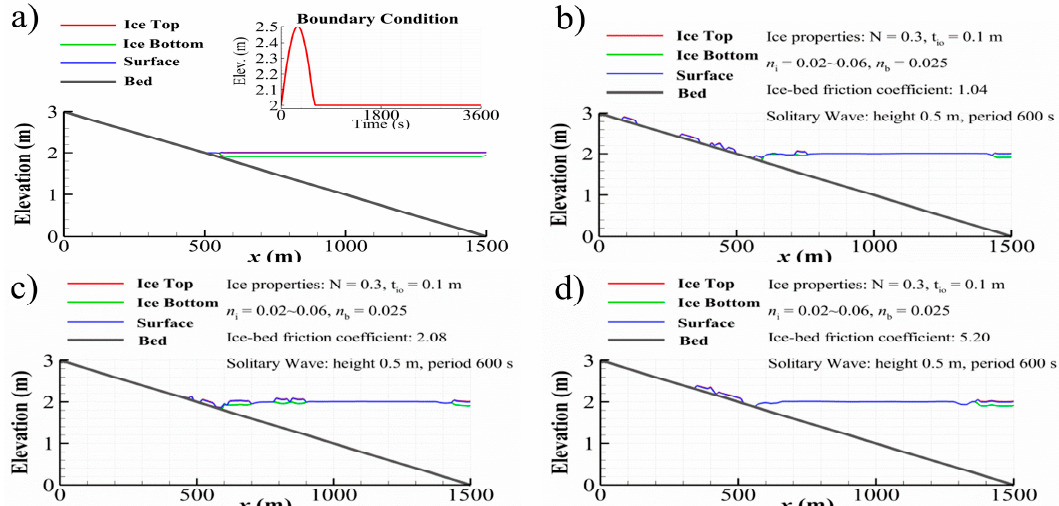
Figure 6. Simulated ice depositions on the beach under a tsunami wave with different ice-bed friction coefficients: ( a ) Initial water surface, ice bottom and top elevations, and the tsunami wave boundary conditions; simulated water surface and ice depositions on the beach with the ice-bed friction coefficient of ( b ) 1.04, ( c ) 2.08, and ( d ) 5.20. The red line in the subfigure is the upstream water level boundary.